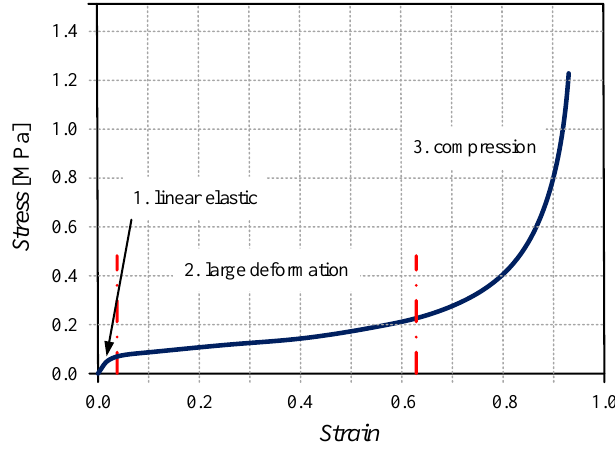
Figure 2. EPS stress-strain diagram.